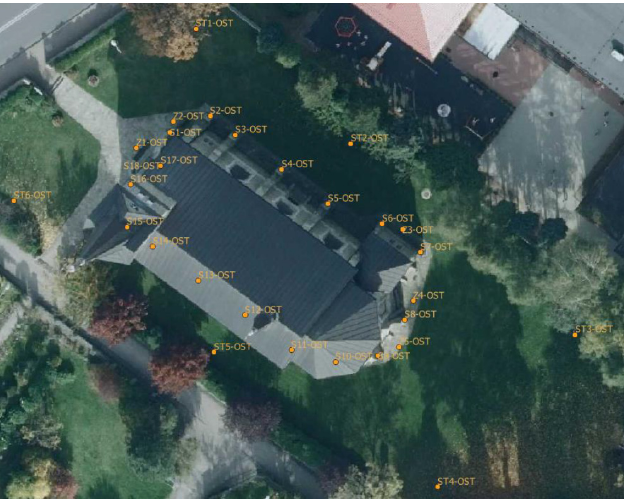
Figure 4. Distribution plan of points of the tacheometric and photogrammetric control networks, which also functions as a thermovision control network.